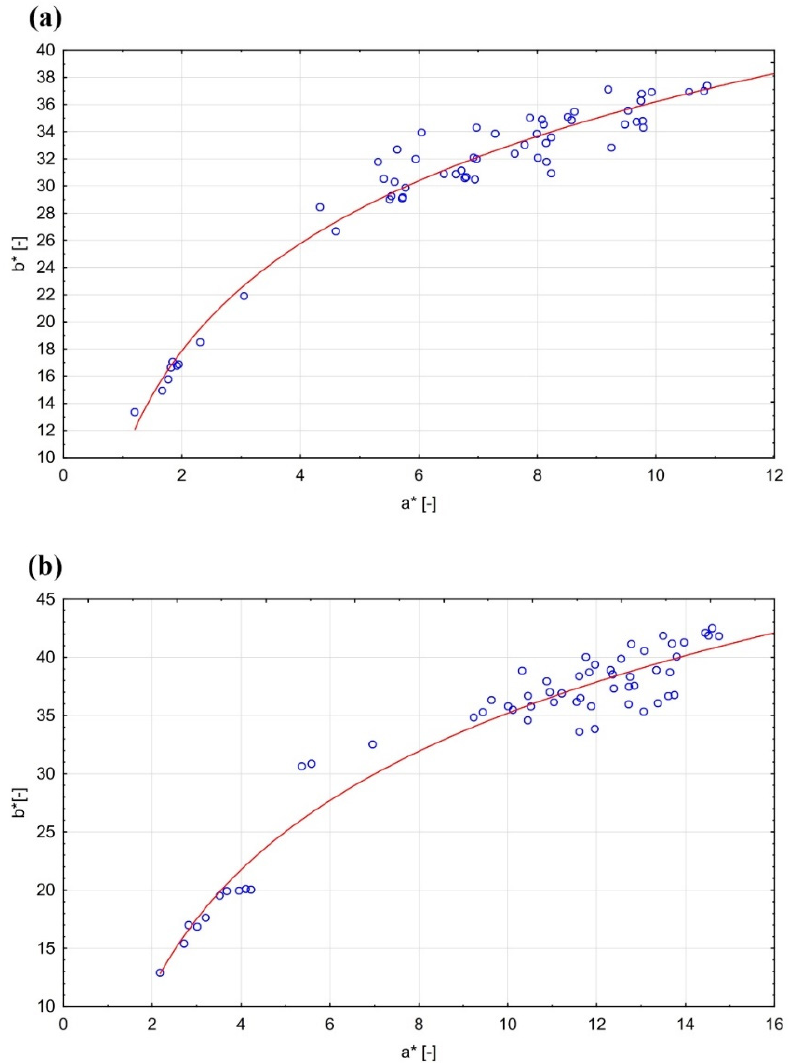
Figure 3. Interdependence of colour space coordinates a* and b* : ( a ) W+MMA; ( b ) W+EMA.